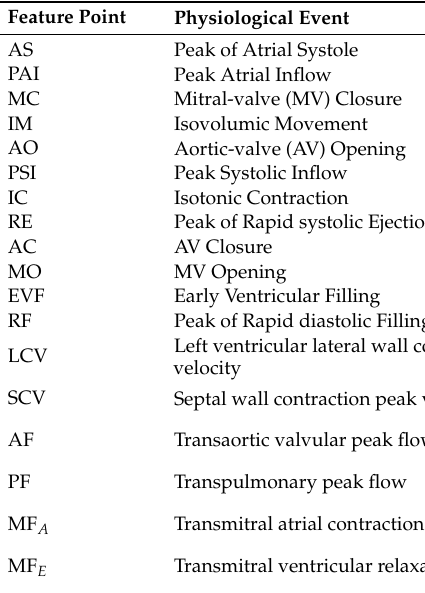
Table 2. SCG feature